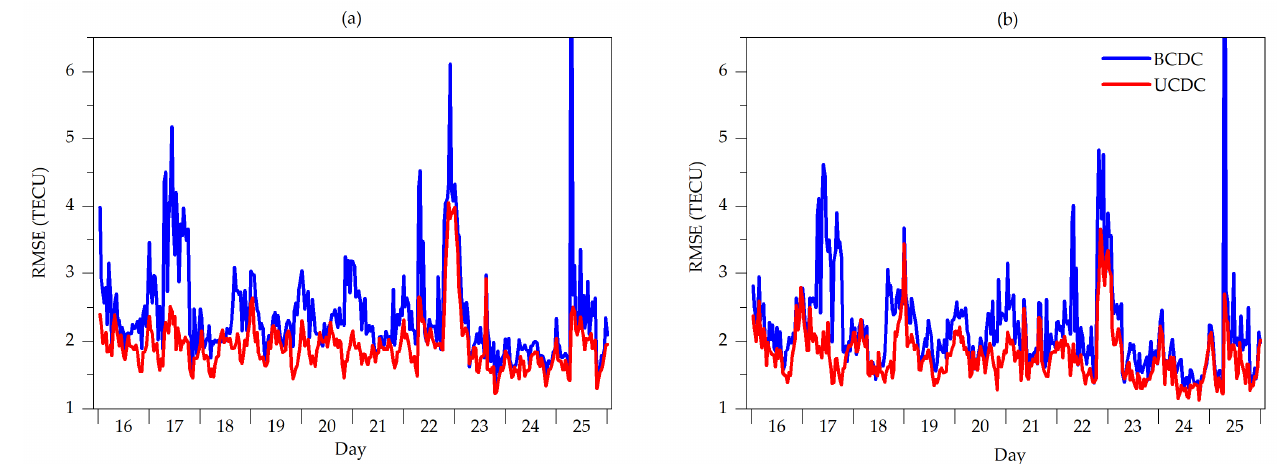
Figure 12. The RMSE s of the STEC parameter at each moment used for tomography ( a ) and cross- validation ( b ). validation ( b